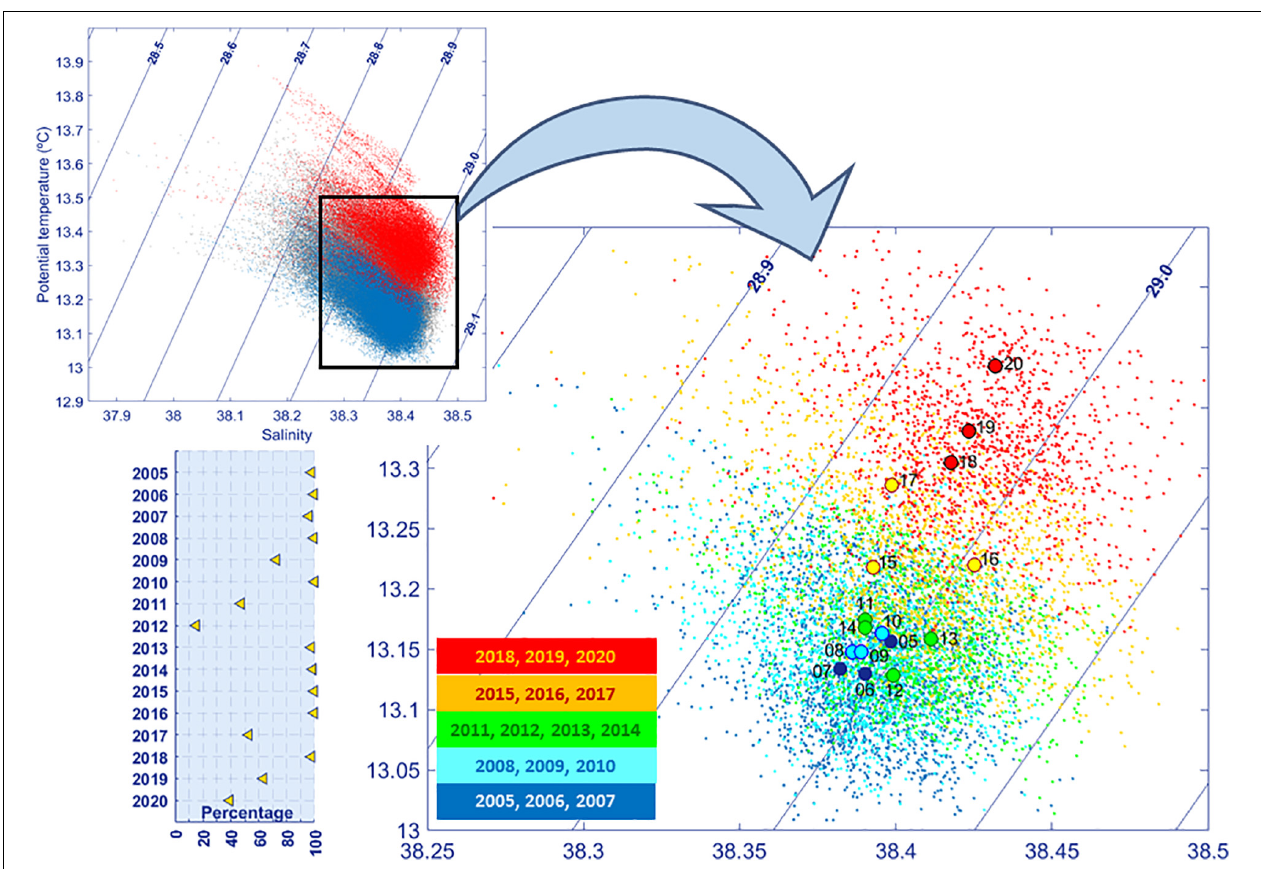
FIGURE 4 | θ − S diagram of the data recorded by the station. Top-left diagram shows the data sampled every 30 min during the first (blue dots) and last (red dots) three years, respectively (see text for definition of “year”). Black rectangle indicates the portion of the diagram enlarged in the right panel. Dots in this diagram correspond to the samples of minimum θ extracted from the whole series. They have been colored by years, according to the code in the legend. Large dots are the mean value of a given year, labelled next to them, and follow the same color code. The percentage of data available each year is indicated in the bottom-left plot: 100% correspond to 17520 30 min-data or 705 minimum- θ -data per